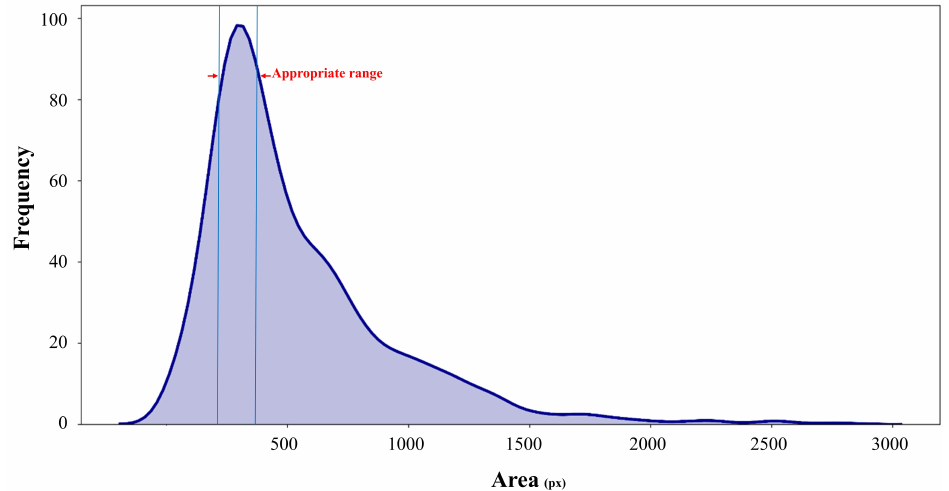
Figure 3. Frequency histogram of the areas of the extracted objects from the binary clustered image. Vertical lines determine the minimum and maximum areas for selecting single plants.